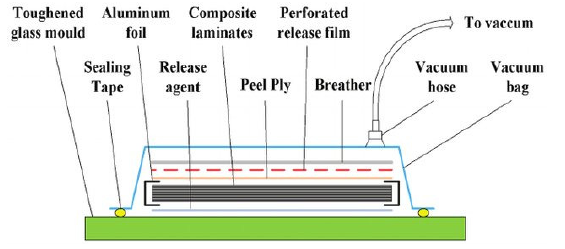
Fig 2: Schematic Vacuum Bagging Process [23] The tensile strength is calculated by the following = (cid:9) !" , where σ is the tensile strength equation. σ (cid:31) (cid:31) #$ P is the maximum force carried by the sample &’(cid:10) before failure. b and h are the width and thickness of the test samples.